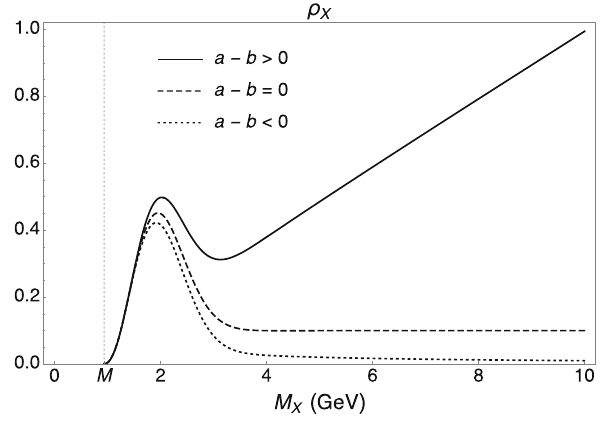
Fig. 2 The spectral function ρ X of Eq. (16) as a function of the spec- tator mass M X (cid:13) × ( M − M ( 1 − x )) 2 + p 2 X